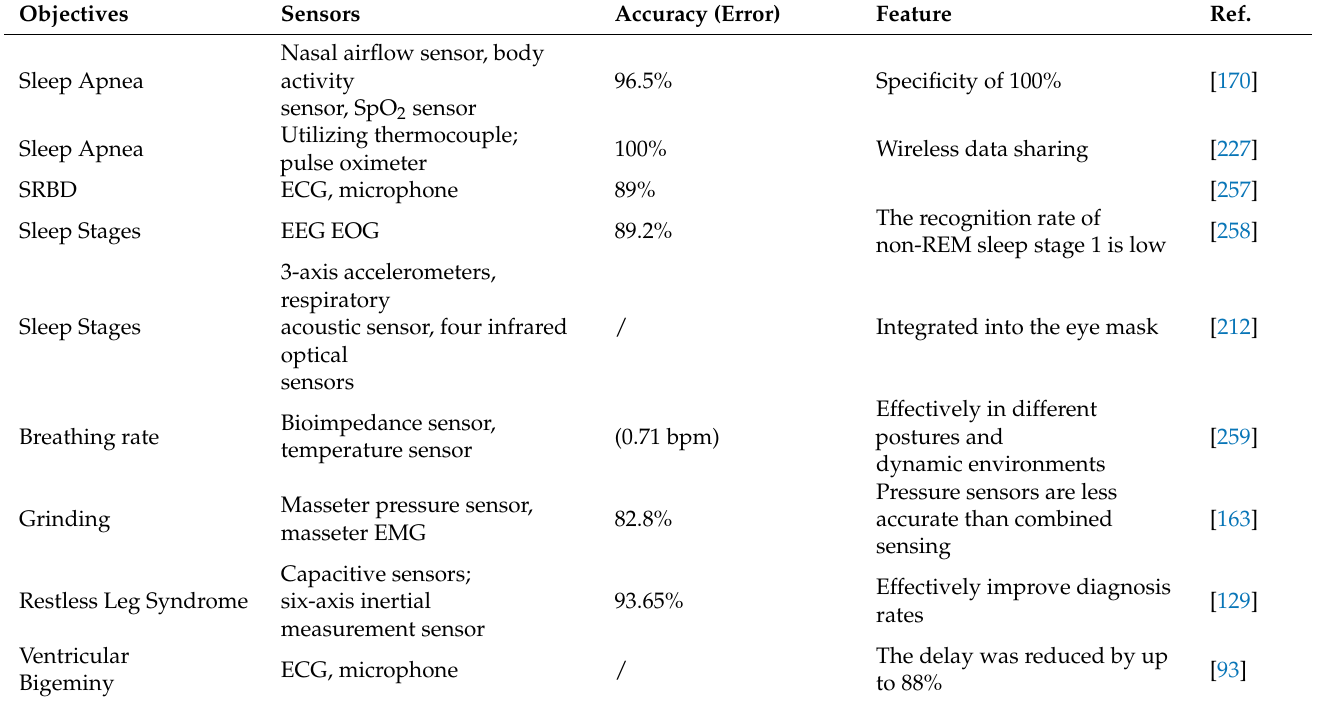
Table 3. Table for analyzing single subject based on multiple sensors.